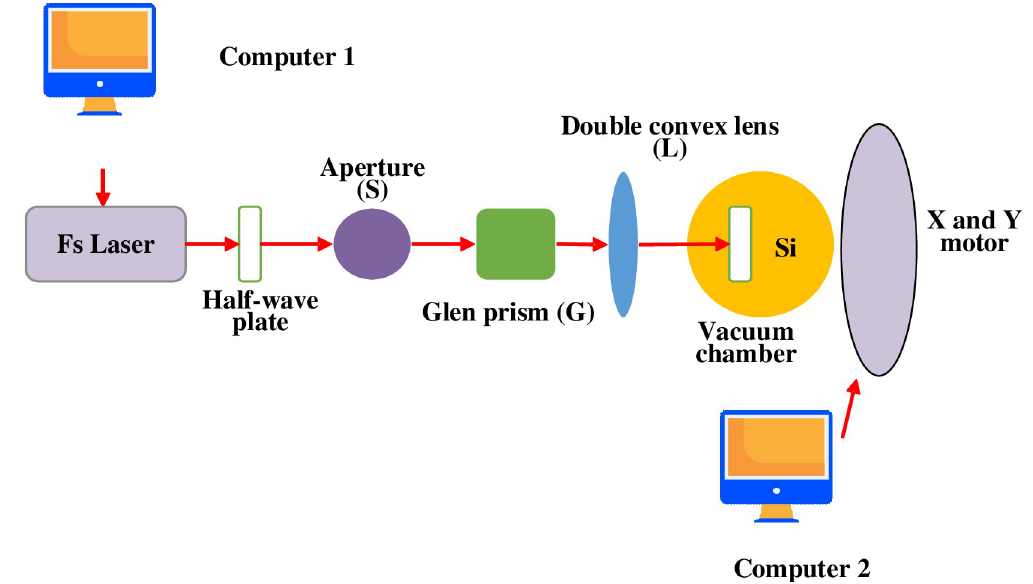
Fig 3. Schematic diagram of FS-based black silicon processing optical system.